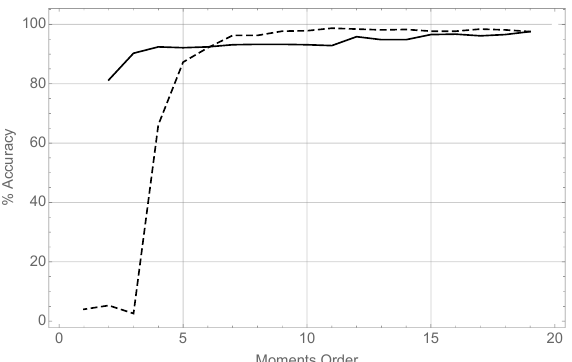
Figure 3. Results of the precision in the recognition tests. The dashed line represents varying moment order in θ while keeping the orders in x and z constant in 19. The solid line represents varying moment order in x and z while keeping the 19th order constant in θ